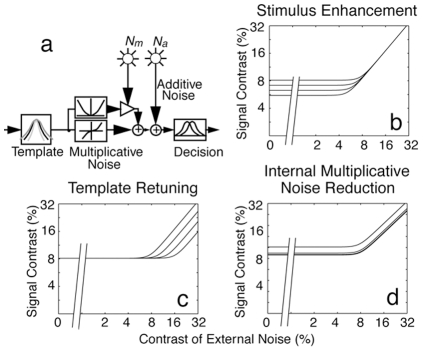
The Perceptual Template Model.(a) The PTM. (b, c, d) Performance signatures of the three mechanisms of perceptual learning.